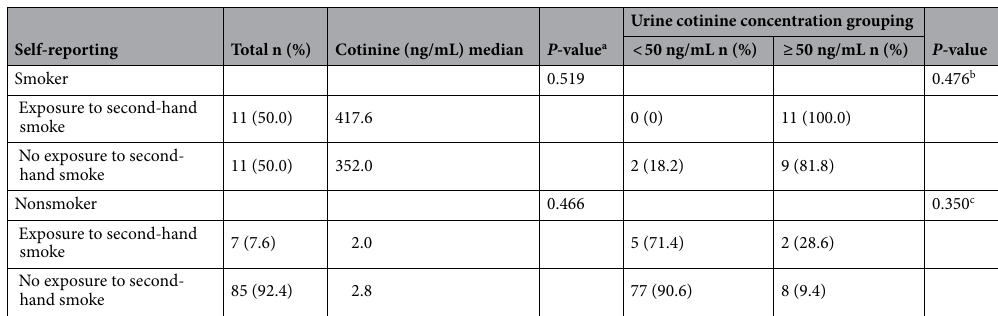
Table 3. Comparison of female volunteer soldiers’ second-hand smoke exposure and urine cotinine concentration. a Mann–Whitney U test; b Fisher’s exact test; c chi-square ( χ 2 ) test.